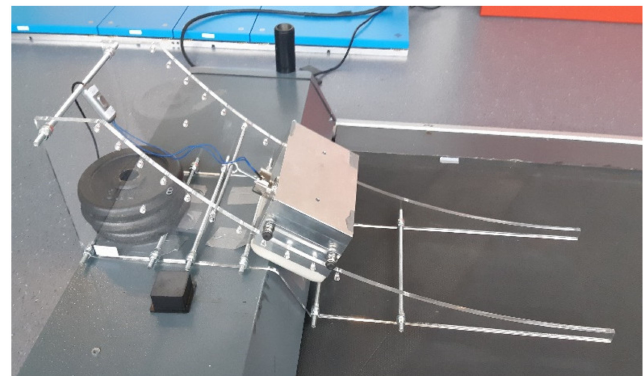
Figure 1. Stumbling device [29] mounted on a